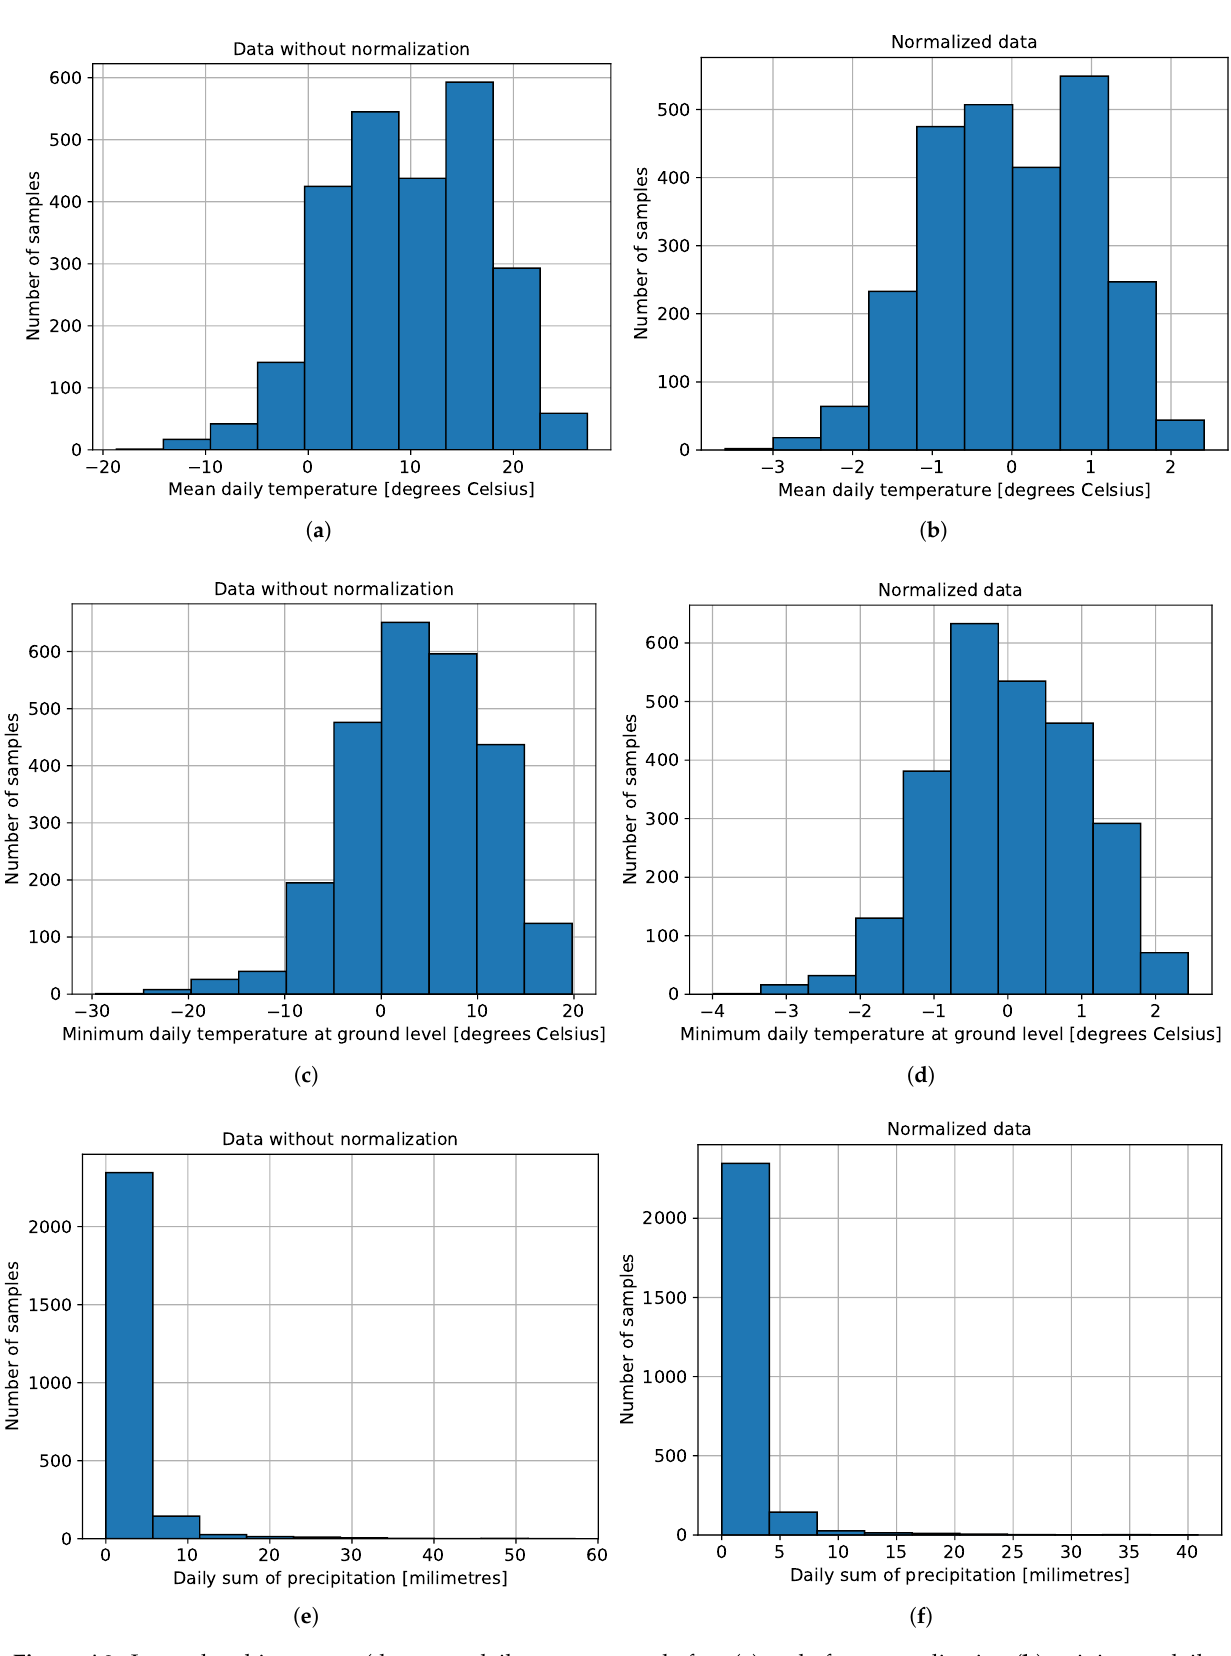
Figure A2. Input data histograms (the mean daily temperature before ( a ) and after normalization ( b ), minimum daily temperature at ground level before ( c ) and after normalization ( d ), and daily sum of precipitation before ( e ) and after normalization ( f